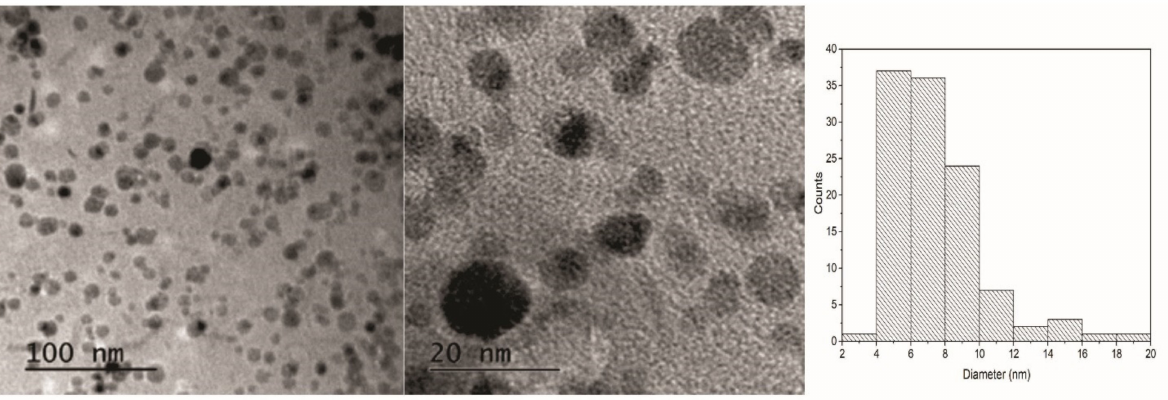
Figure 6. TEM micrographs of MNPs in the elastomeric matrix and the histogram corresponding to the MNPs’ distribution.